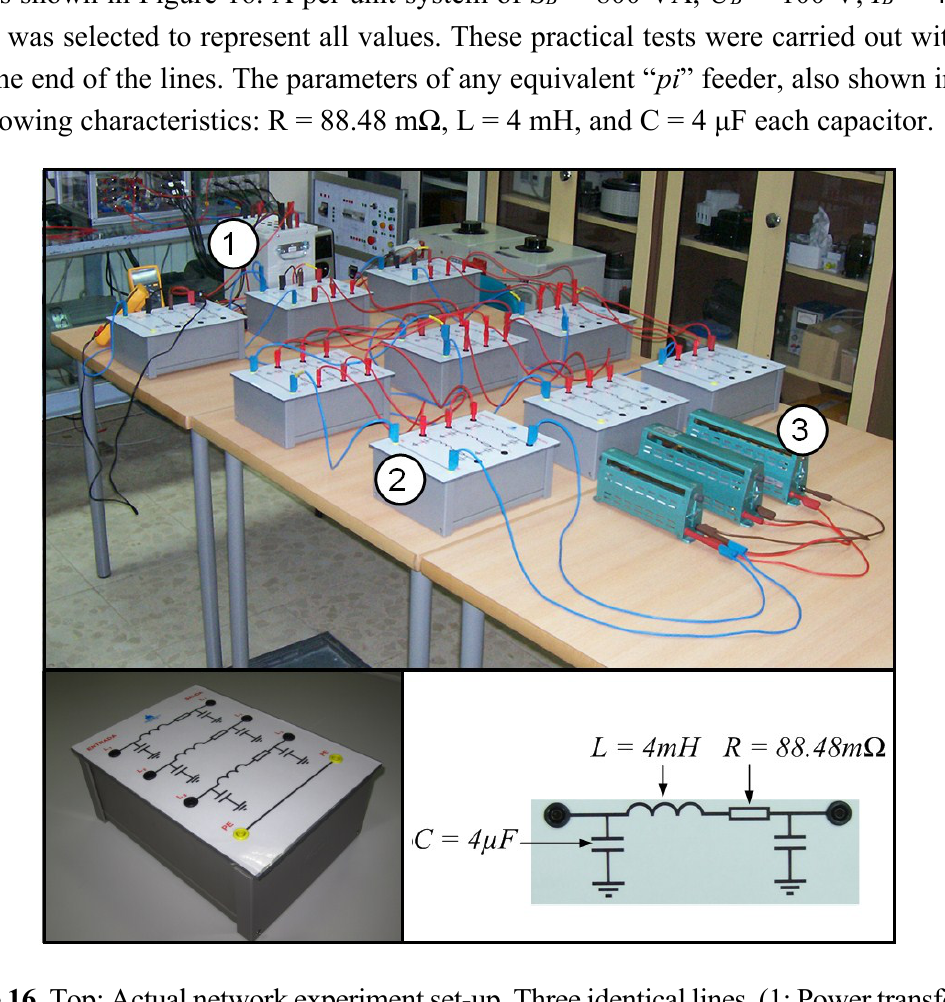
Figure 16. Top: Actual network experiment set-up. Three identical lines. (1: Power transformer, 2: Equivalent “ pi ” module, 3: Ground fault resistance). Bottom: Equivalent “ pi ” module and parameter